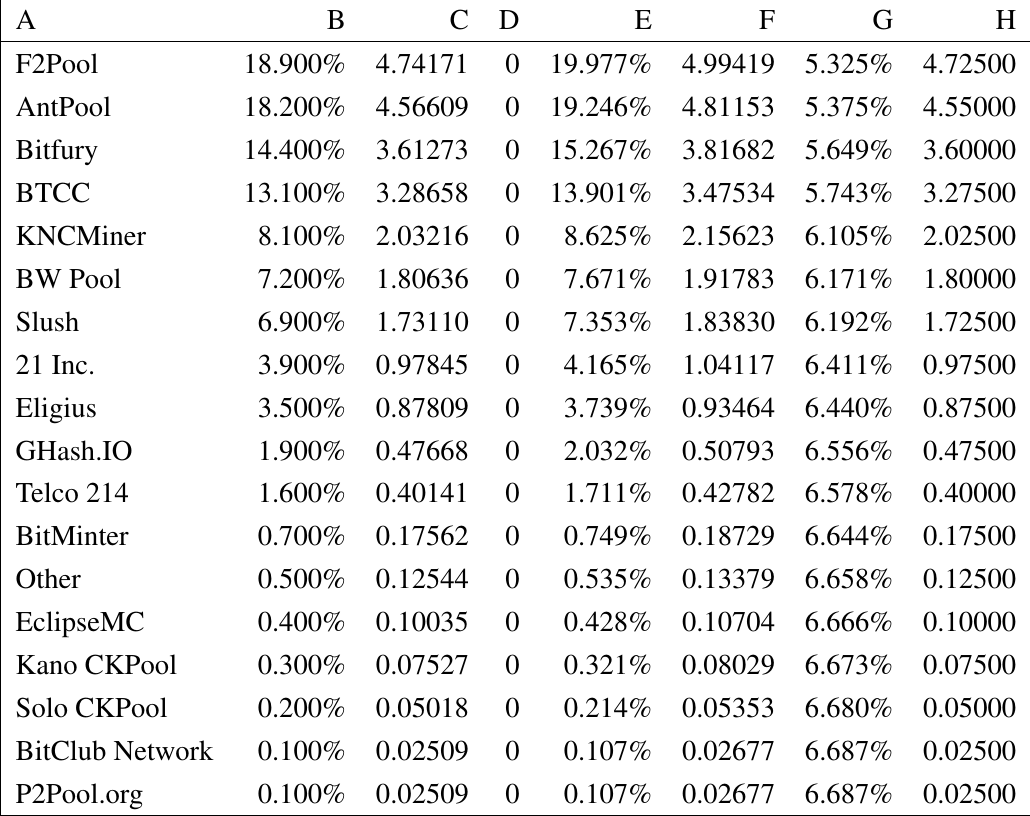
Table 3. k b = 0 . 08. A: miner’s name, B: relative computational power, C: expected reward when ∀ i ∈ N , Q i = 884 × 0 . 6 kB , D: optimal number of transaction included by miner i in the current block when ∀ j ∈ N \{ i } , Q j = 884 × 0 . 6 kB (solution to Equation 3), E: probability